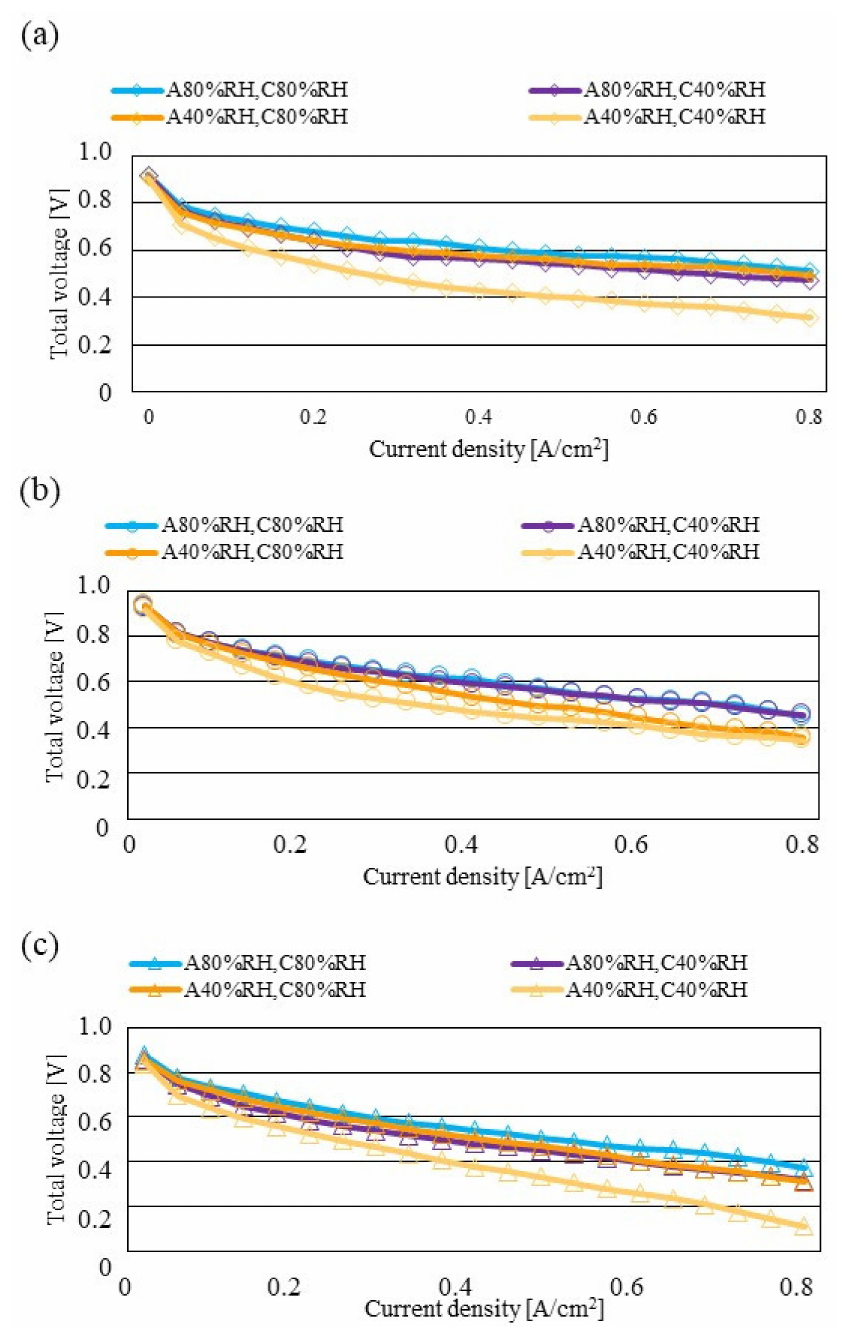
Figure 12. Comparison of polarization curves, among different RHs using the separator thickness of 1.0 mm: ( a ) the initial operation temperature = 80 ◦ C, ( b ) the initial operation temperature = 90 ◦ C, ( c ) the initial operation temperature = 100 ◦